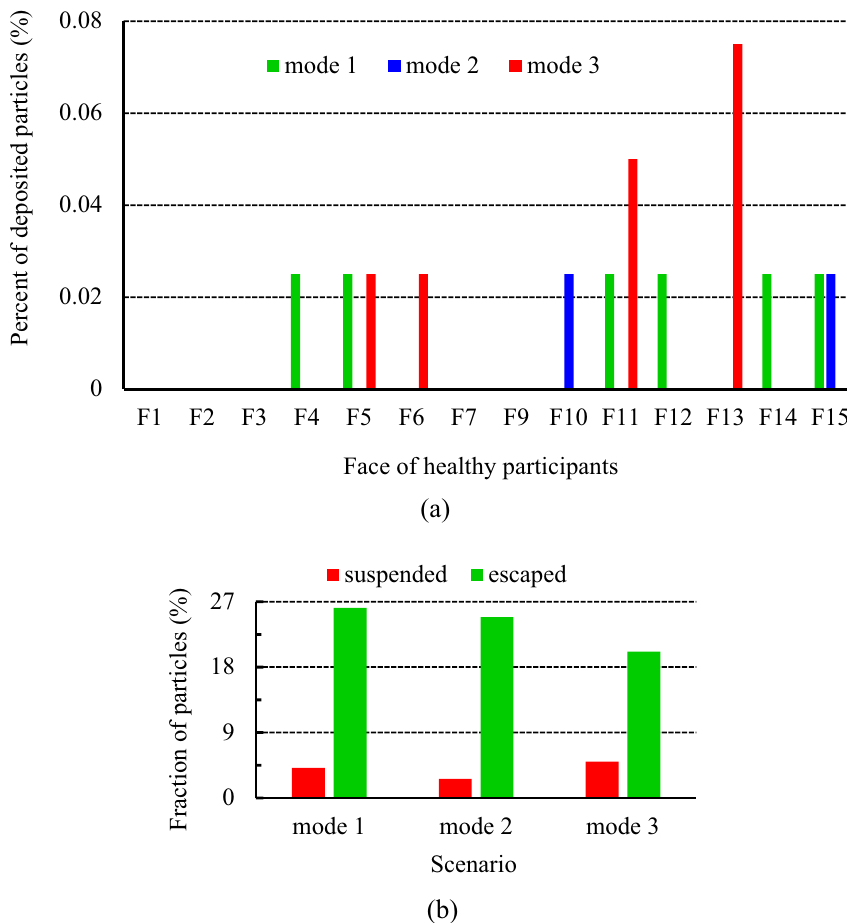
Figure 18. Effects of the air-conditioner location on the exposure risk of healthy participants during scenarios 11 through 13; ( a ) the fraction of the particles deposited on the healthy individuals’ faces, and ( b ) the fraction of the suspended and escaped particles at the end of particle